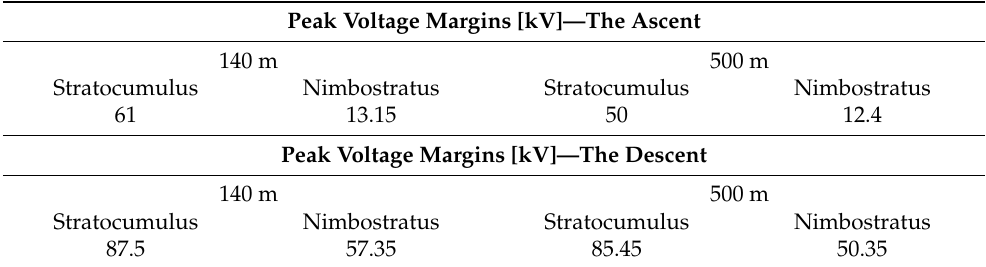
Figure 9. The flashover and induced voltage for the re-entry through the Nimbostratus clouds on the 500 m-long fully airborne antenna. Table 1. Minimum obtainable peak voltage margins due to electrification processes and flashover limits for a fully airborne vertical VLF antenna of two lengths.